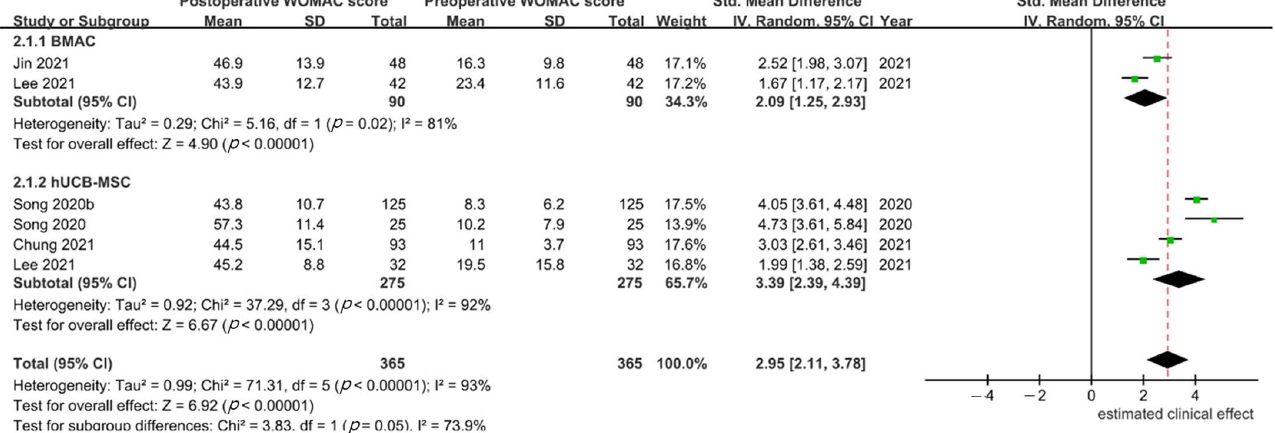
Figure 3. Figure 3. Estimated clinical effects of bone marrow aspirate concentrate (BMAC) and human umbilical cord blood-derived mesenchymal stem cells (hUCB-MSCs) in knee osteoarthritis (OA) patients treated with high tibial osteotomy (HTO) based on the Western Ontario and McMaster Universities OA Index (WOMAC)